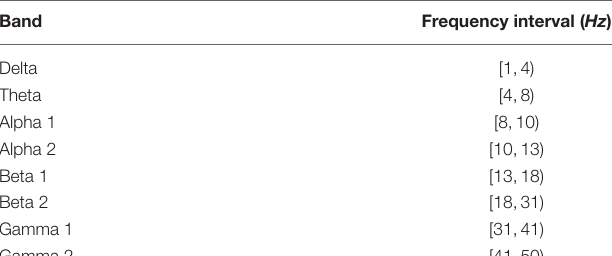
TABLE 1 | Frequency bands analyzed.